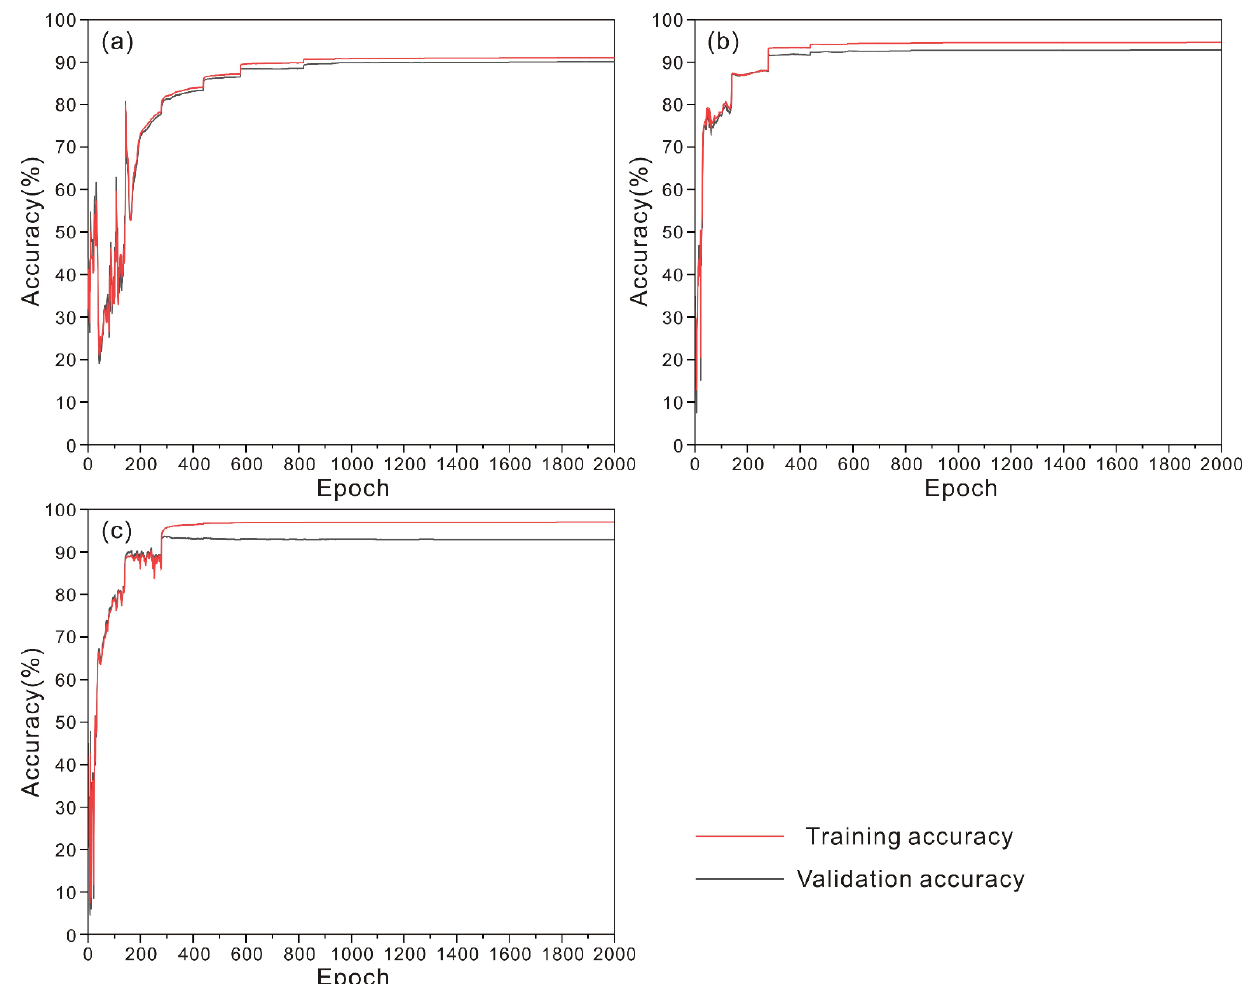
Figure 10. Training and validation accuracies of DNN models. ( a ) Training and validation